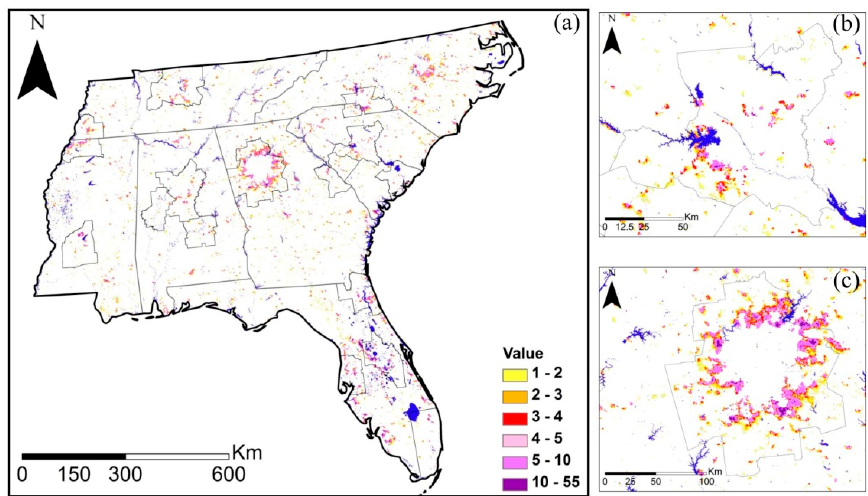
Figure 3. Changing trends (%) per year in VANUI across the Southeast U.S.A. based on the linear regression analysis, with ( a ) Southeast U.S.A.; ( b ) Columbia, SC; and ( c ) Atlanta, GA.